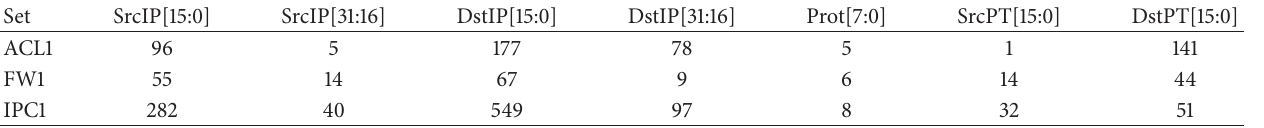
Table 2: | UR | for real